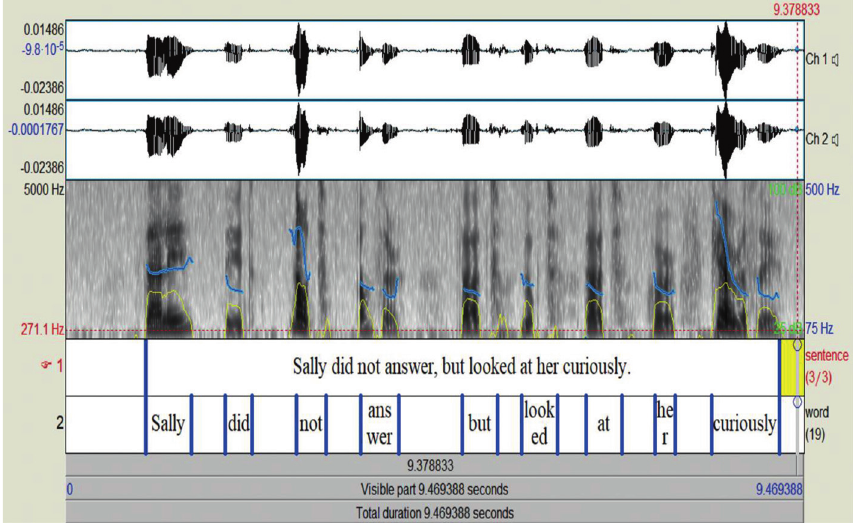
Figure 2: Spectrogram of sentence 3 from native